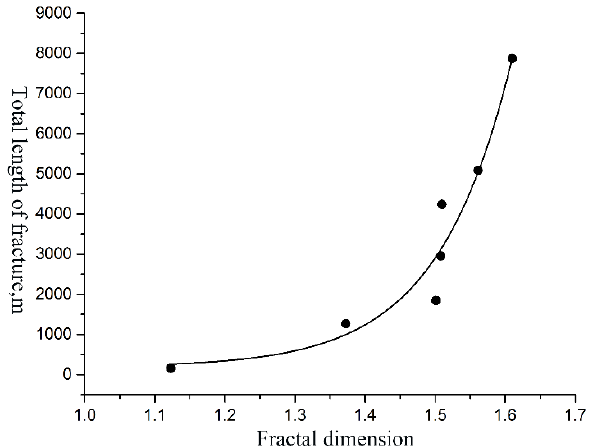
Figure 5. Total length of fracture of rock mass versus fractal